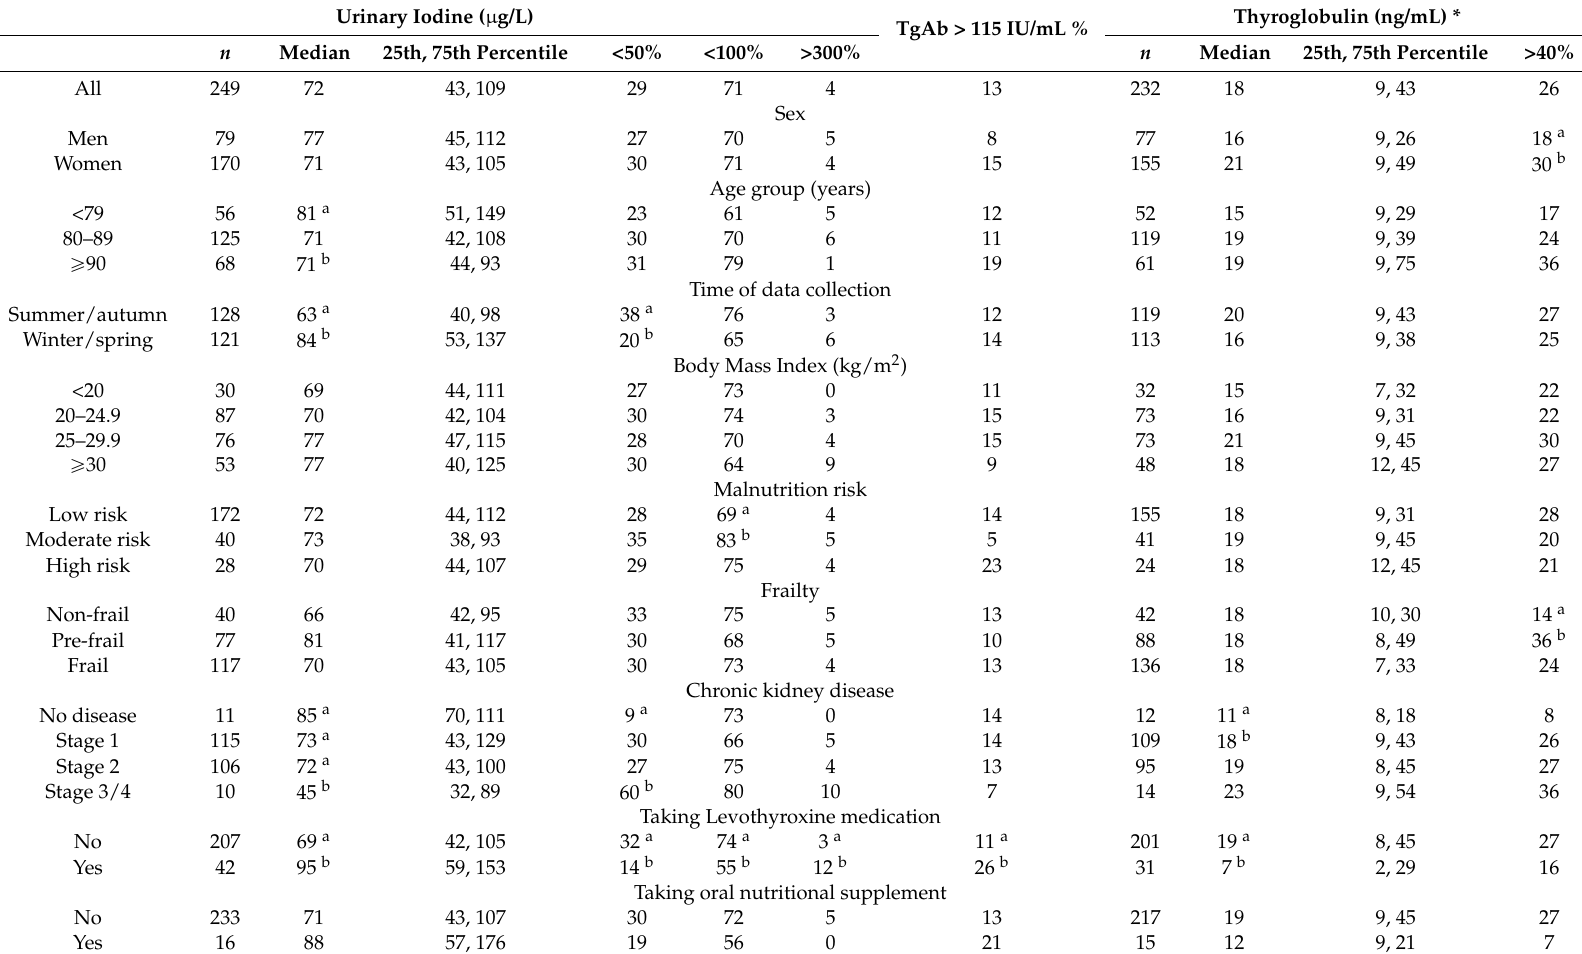
Table 2. Urinary iodine and serum thyroglobulin concentration of rest home residents in New